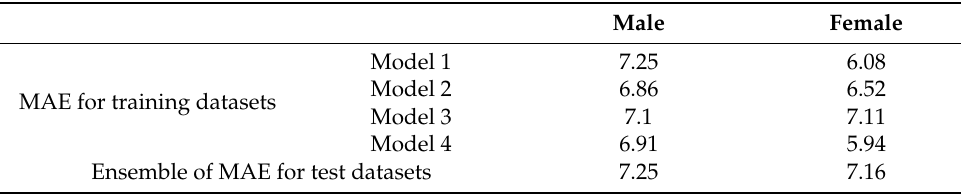
Table 3. Results of 4-fold